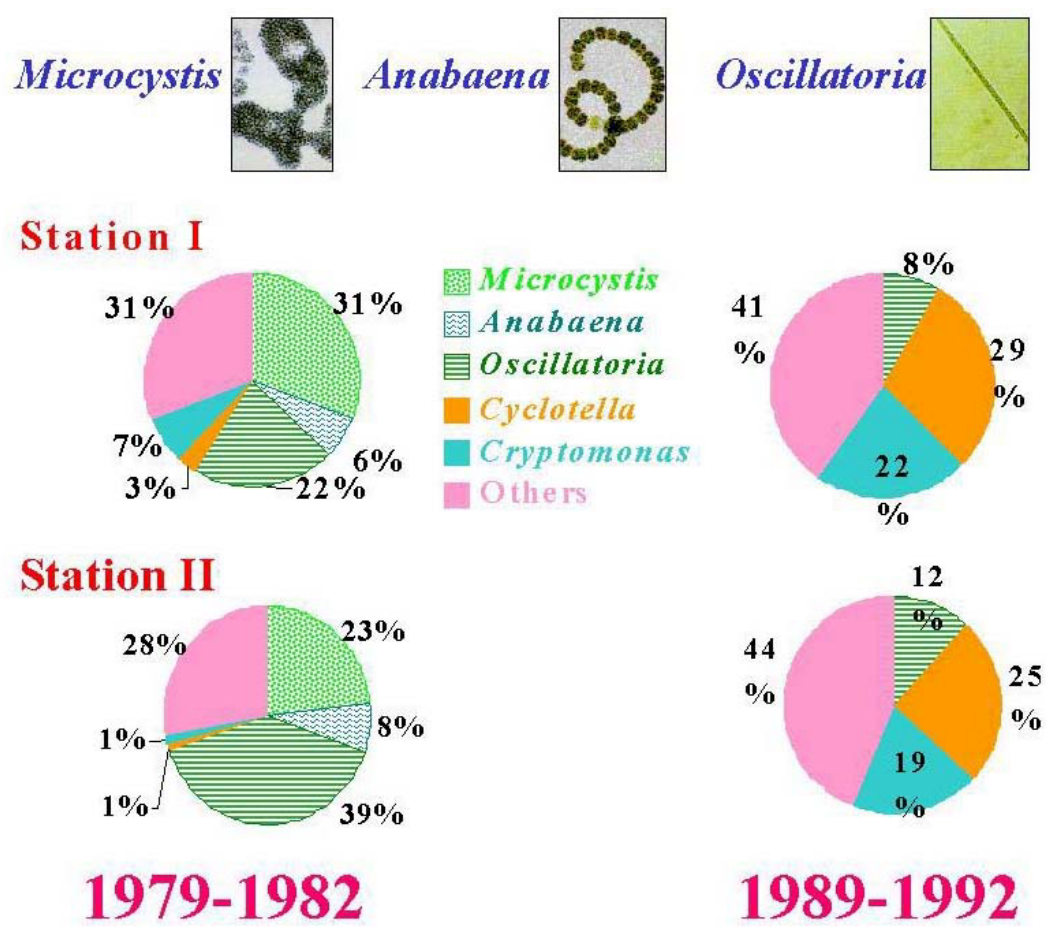
FIGURE 4. Annual mean biomass (%) of dominant phytoplankton at two sampling stations of Lake Donghu between 1979–1982 and 1989–1992 (1979–1982 data from